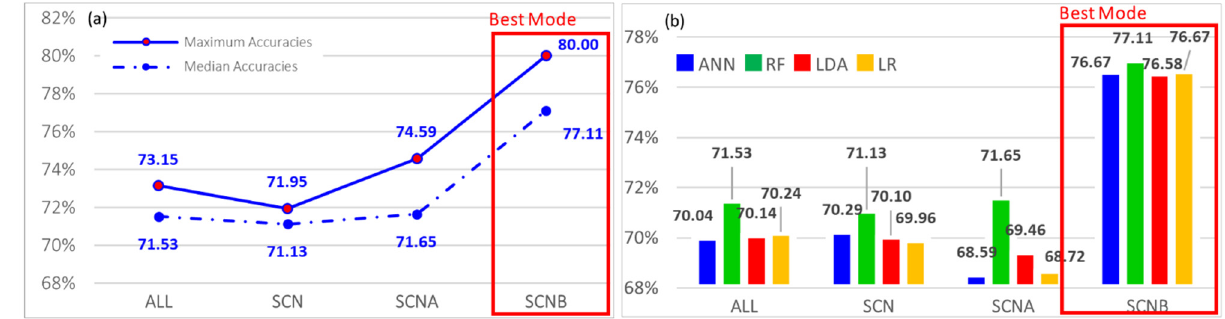
Figure 8. ( a ) Maximum accuracies and median accuracies for all, SCN, SCNA, and SCNB beam modes. ( b ) Median accuracies obtained by the ML algorithms for the same data groups.